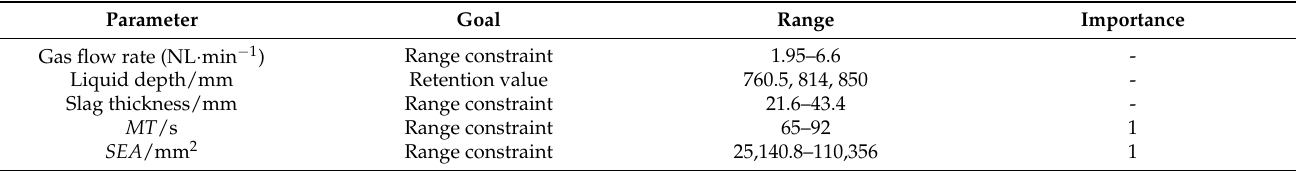
Table 10. Optimization